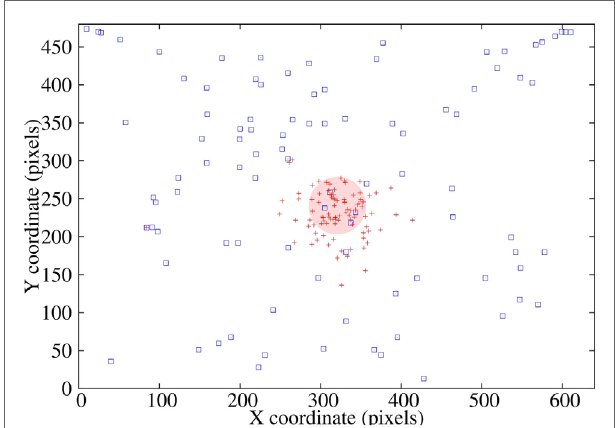
FigUre 9 | Prediction performance: position of the stimulus after two predictions for 95 random initial positions